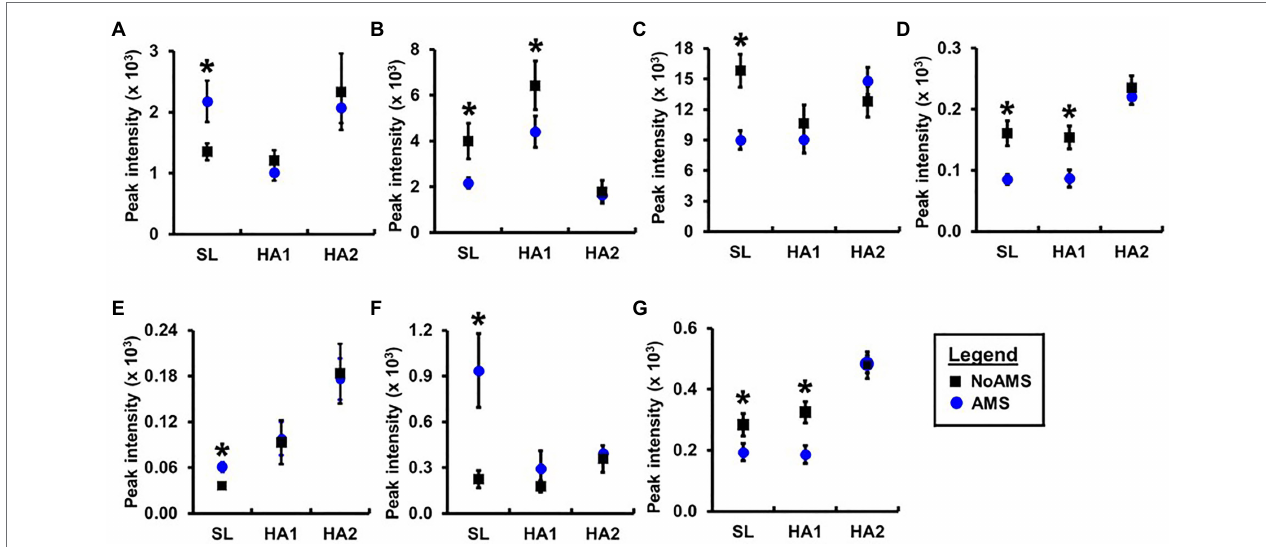
FIGURE 5 | Relative peak intensities of (A) 4-hydroxyphenylpyruvate, (B) taurine, (C) N-methylhistidine, (D) hypoxanthine, (E) acetylcarnitine, unidentified peaks at (F) 3.33 ppm (doublet) and (G) 8.20 ppm (singlet) in 1H nuclear magnetic resonance (NMR) spectral data for urine samples collected from AMS susceptible (blue symbol) and NoAMS resistant subjects (black symbol) at SL, and 4,300 m on day 1 (HA1) and day 18 (HA2). Asterisk denotes significant difference between groups ( p ≤